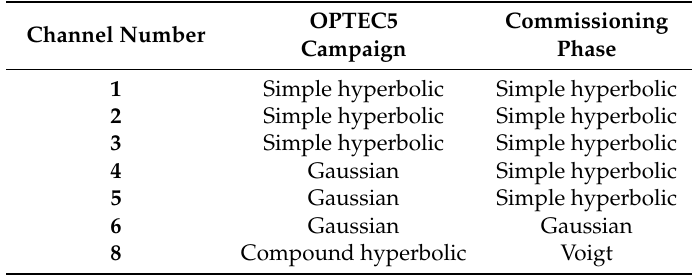
Table 2. Recommended analytical functions for the ISRF function in seven channels of the SCIAMACHY instrument. Channel 7 was not included in the table as it was not analyzed in this study. The second column’s functions were retrieved from on ground measurements during the OPTEC5 campaign. The third column’s were obtained during the commissioning